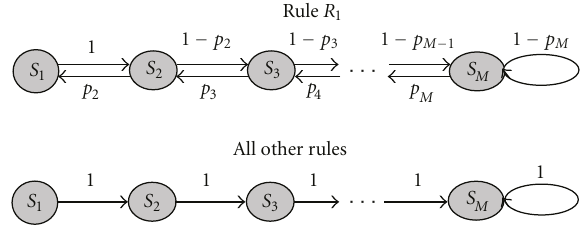
Figure 12: Worst case Markov chain for updating Q ( S 1 ), random walk on a